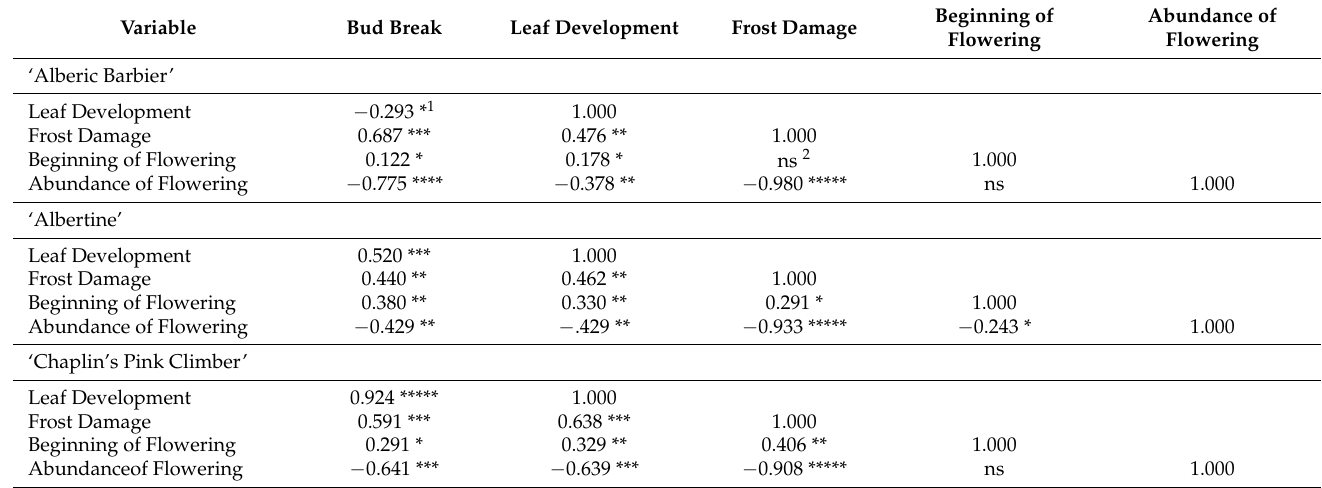
Table 12. Correlations matrices between frost damage, early phenology stages, and beginning and abundance of flowering in climber roses for: ‘Alberic Barbier’, ‘Albertine’, ‘Chaplin’s Pink Climber’, ‘Dr Robert Huey’, ‘Duc de Constantin’, ‘Gerbe Rose’, ‘Mme Plantier’, and ‘Orange Triumph